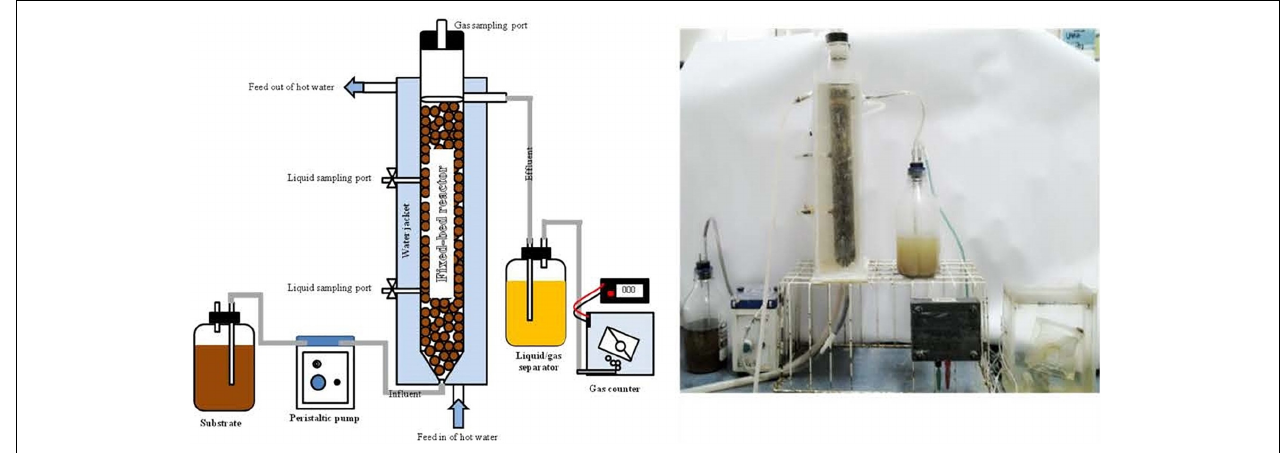
FIGURE 1 | Schematic diagram of the fixed-bed reactor operated under non-sterile conditions at 60 ◦ C.